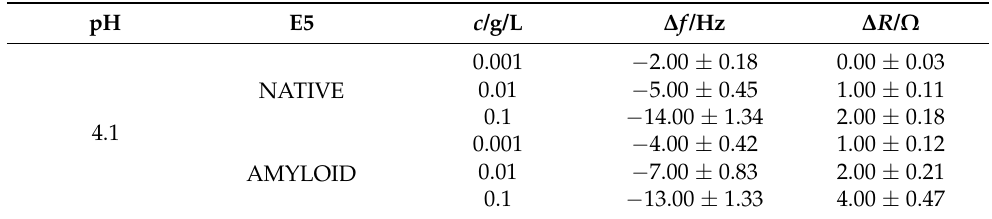
Table 4. Frequency change ( ∆ f ) and resistance change ( ∆ R ) determined in QCM measurement during adsorption of E5 miniprotein at various